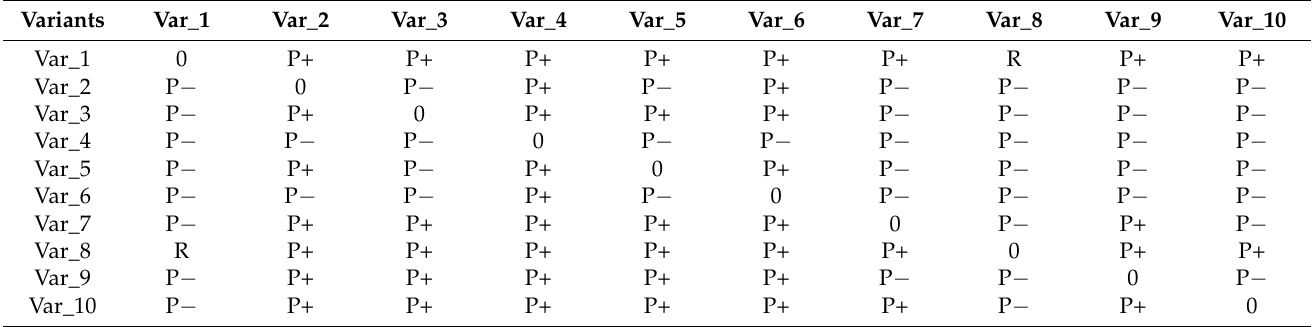
Table 12. Dominance matrix values from the point of view of the surveyed